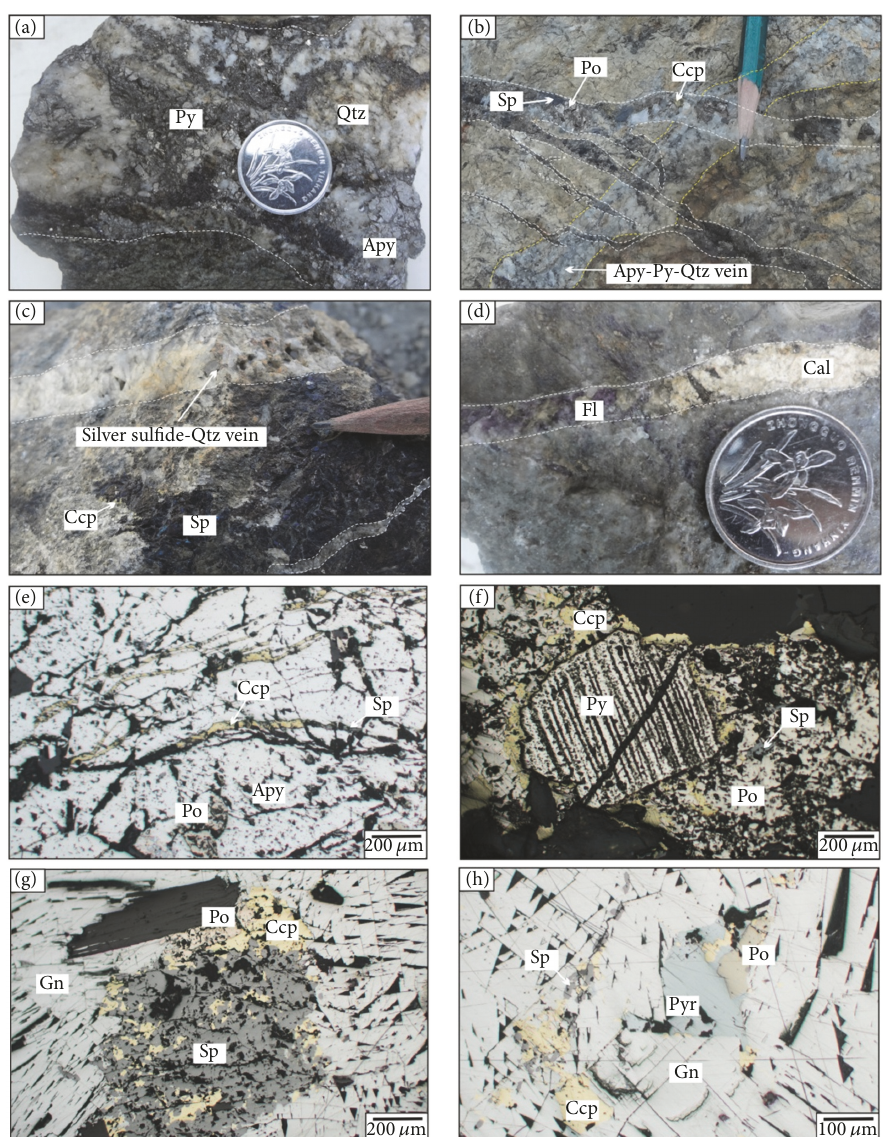
Figure 3: Photographs and photomicrographs of ore from the Bairendaba Ag-Zn-Pb deposit. (a) Quartz-pyrite-arsenopyrite vein. (b) Quartz-pyrite-arsenopyrite vein cut by quartz-pyrrhotite-chalcopyrite-sphalerite vein. (c) Quartz-pyrrhotite-chalcopyrite-sphalerite vein cut by Ag-sulfide quartz vein. (d) Calcite-fluorite vein. (e) Galena cut by chalcopyrite-sphalerite vein. (f) Pyrite replaced by pyrrhotite- chalcopyrite-sphalerite aggregate. (g) Pyrrhotite-chalcopyrite-sphalerite aggregate replaced by galena. (h) Pyrargyrite in galena. Qz (quartz); Po (pyrrhotite); Py (pyrite); Ccp (chalcopyrite); Sp (sphalerite); Gn (galena); Pyr